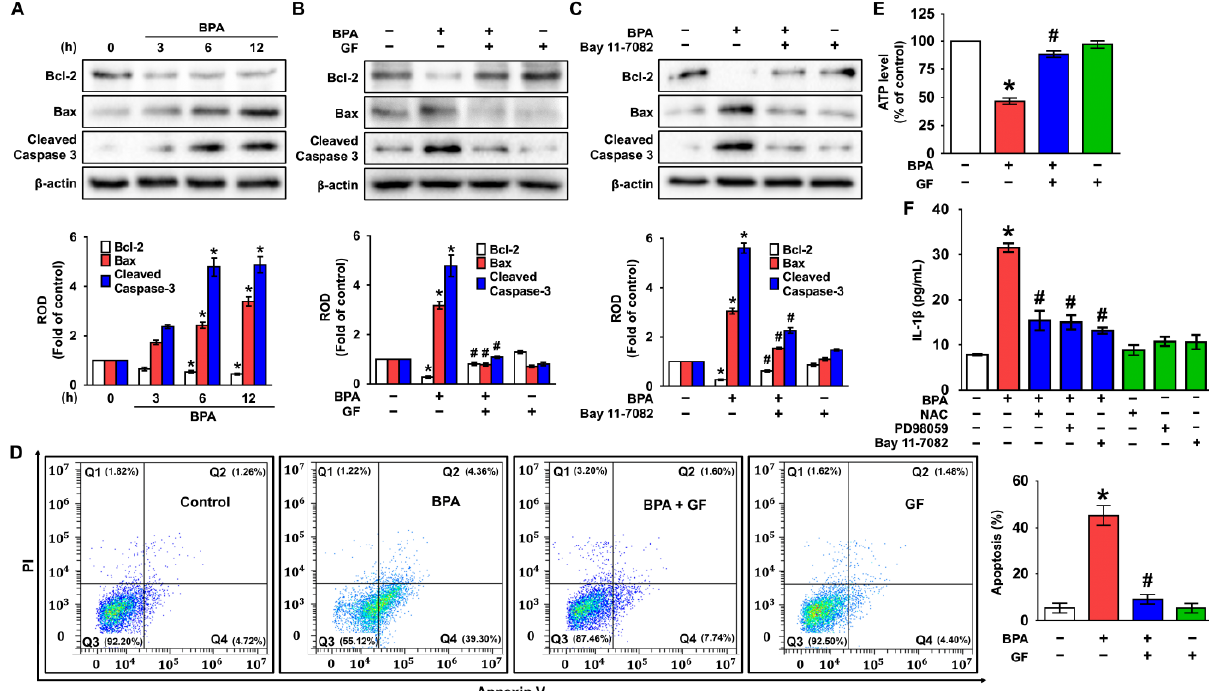
Figure 6. GF blocks dermal fibroblastic apoptosis and inflammation caused by BPA. ( A ) Time-dependent response of expression of cleaved caspase-3, Bcl-2, and Bax in NHDFs exposed by BPA are shown. n = 3. * p ≤ 0.05 vs. 0 h. ROD, relative optical density. ( B ) The inhibitory effects of GF on expression of apoptosis-related proteins in BPA-treated NHDFs are shown. n = 4. * p ≤ 0.01 vs. Cont., # p ≤ 0.01 vs. BPA alone. ( C ) NHDFs were pretreated with Bay 11-7082 for 30 min prior to BPA exposure for 6 h. n = 4. * p ≤ 0.01 vs. Cont. # p ≤ 0.01 vs. BPA alone. ( D ) NHDFs were incubated with GF for 30 min prior to BPA exposure for 6 h. The apoptotic cell proportion stained by Annexin V/PI was analyzed by performing flow cytometry. n = 4. * p ≤ 0.01 vs. control. ( E ) The level of ATP production regulated by GF in BPA-treated NHDF for 6 h. * p ≤ 0.05 vs. Cont. # p ≤ 0.01 vs. BPA alone. n = 4. ( F ) Cells were treated with NAC, PD98059, and Bay11-7082 for 30 min prior to BPA exposure for 6 h. w is shown. * p ≤ 0.01 vs. Cont. # p ≤ 0.05 vs. BPA alone. n = 4. The green squares indicate the cells treated with GF, NAC, PD98059, or Bay 11-7082